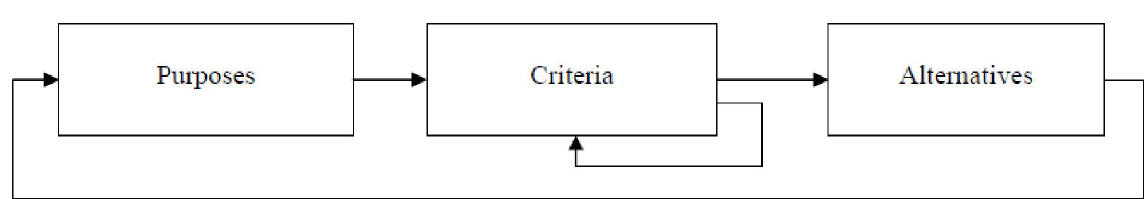
Fig.1. Feedback system